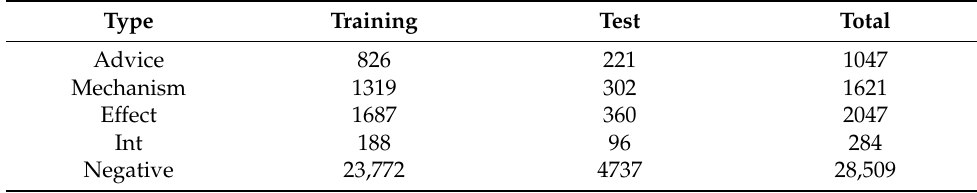
Table 1. The statistics information of DDIExtraction 2013